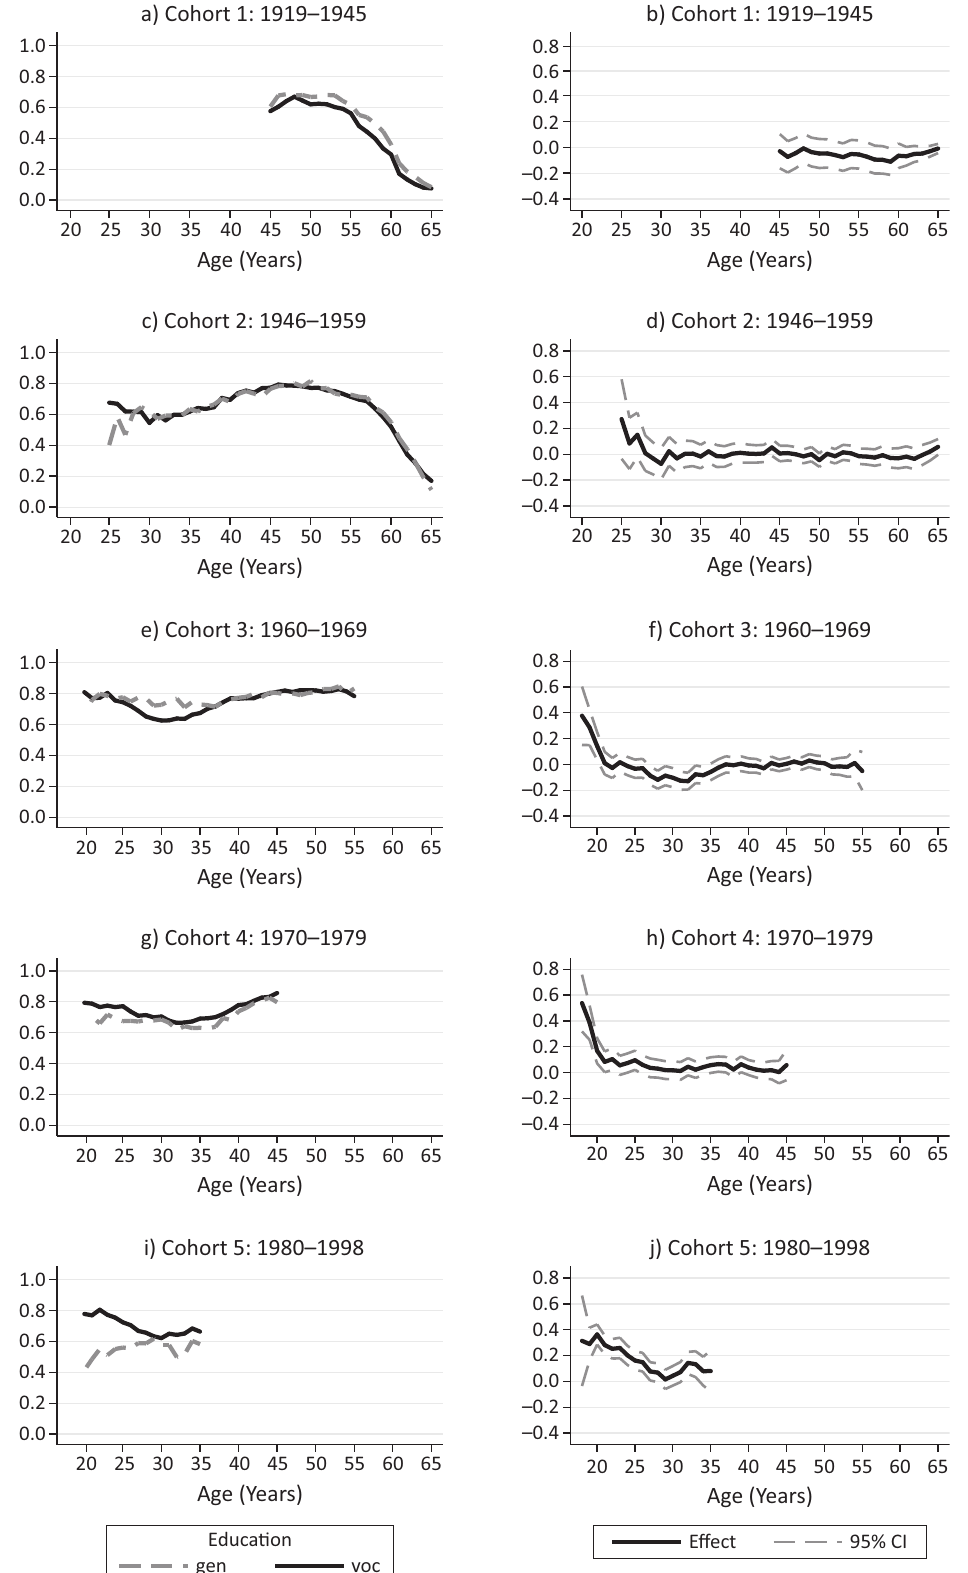
Figure A4. Cohort variation in employment opportunity over the life course: General versus vocational education (women), net of double qualifications (women). Notes: Conditional profile plots (left) and conditional effect plots (right) estimated by cohort-specific non-parametric state probability models of vocational and general education on employment probabilities of women. Control variables include period effects, German nationality, parental educational background, residence in West Germany, and educational level. Detailed regression results available upon request. Data source: GSOEP